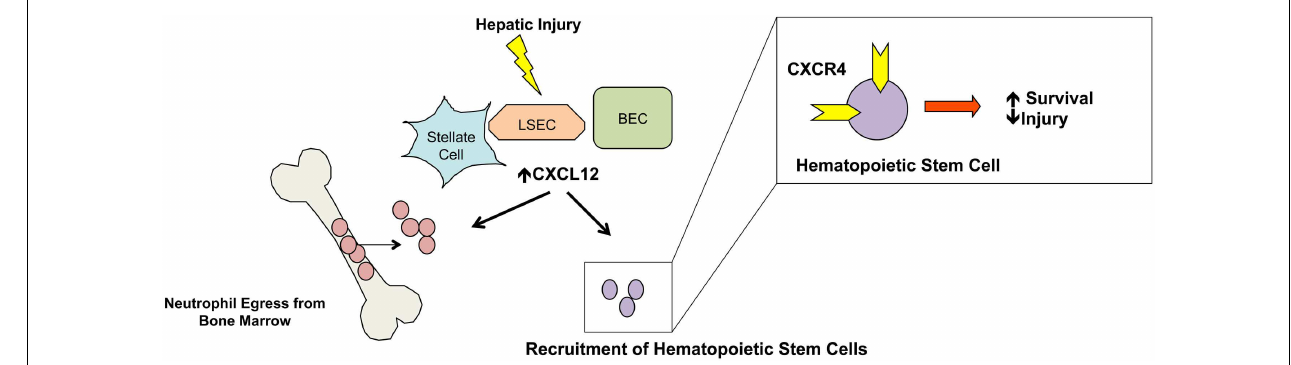
regulated by CXCL12 and increased levels of hepatic and serum levels promotes neutrophil egress.While not depicted, nearly 50% of liver infiltrating cells are CXCR4 positive and localized around CXCL12-rich periportal